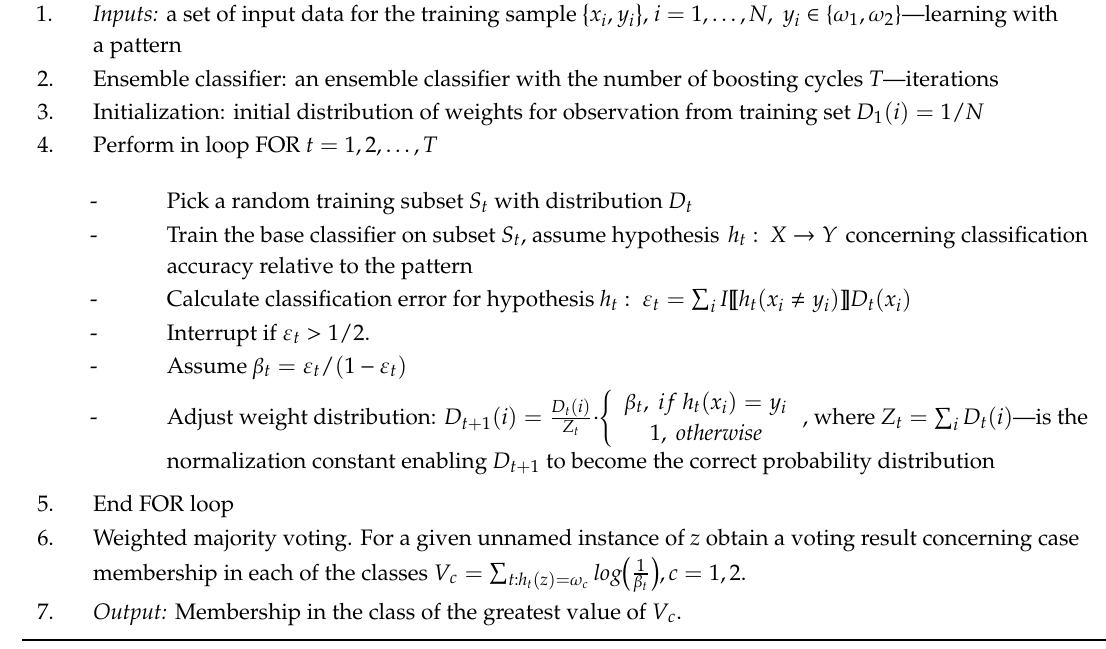
Algorithm 1 AdaBoost.M1 algorithm